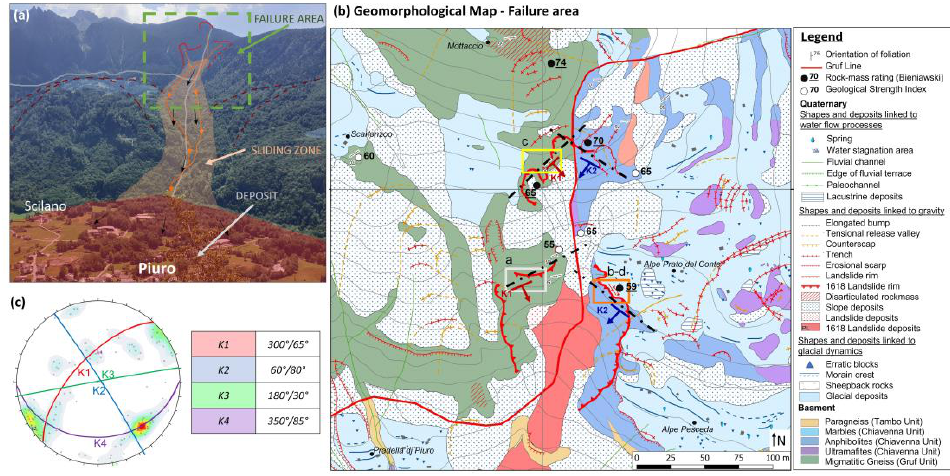
Figure 2. ( a ) Photo of the Piuro landslide as seen from the opposite slope. Failure, sliding and deposit zones are highlighted; ( b ) Geomorphological and geological features of the 1618 failure area; ( c ) Geomechanical features of the study area. Lower hemisphere stereographic projection of the main discontinuity sets. Joint orientation is expressed by dip direction/dip.